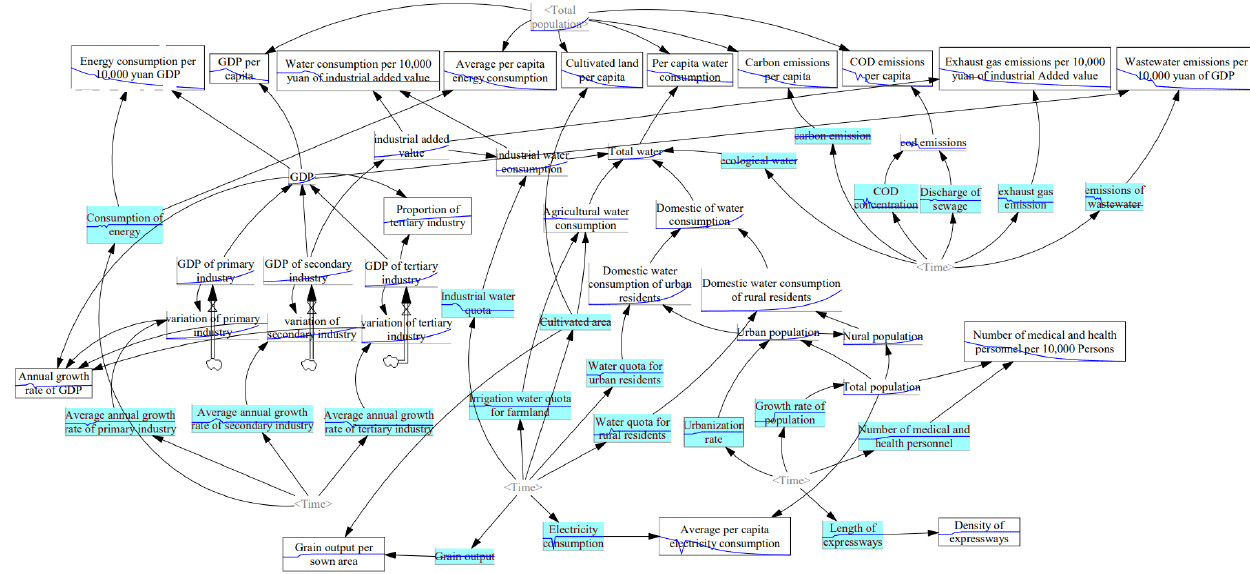
Figure 2. Governance model diagram. Table 4. The test results of the